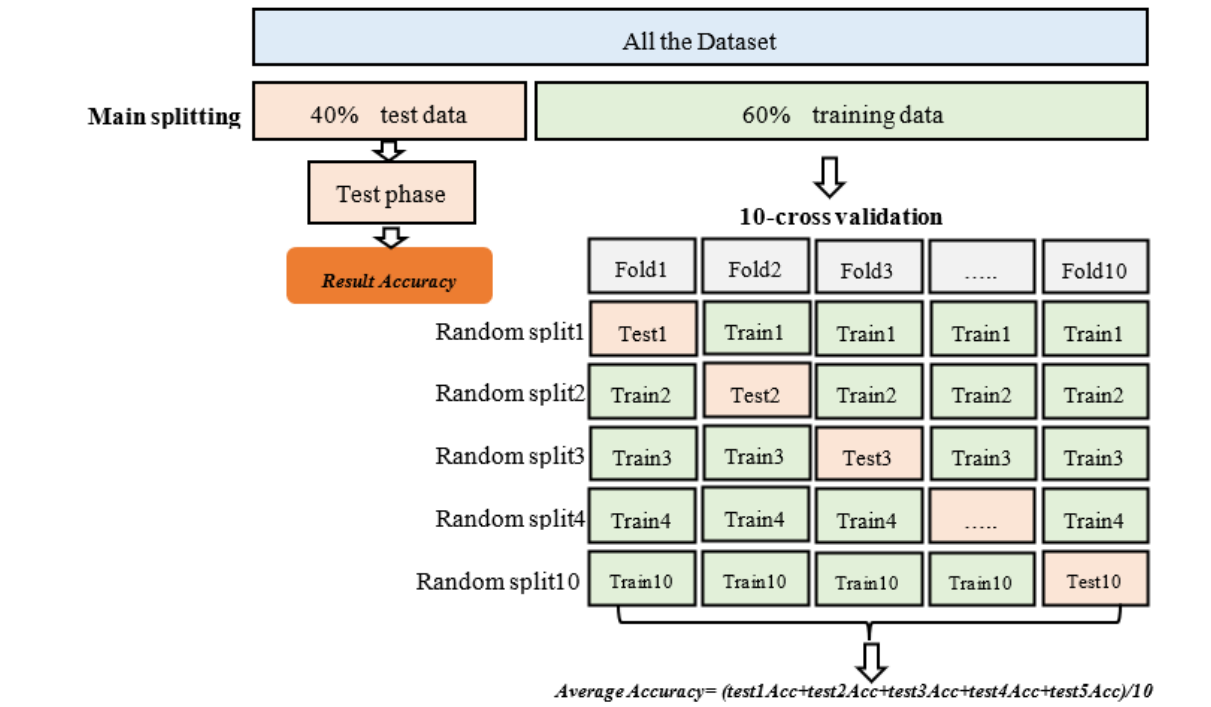
Figure 5. 10-Fold cross validation.